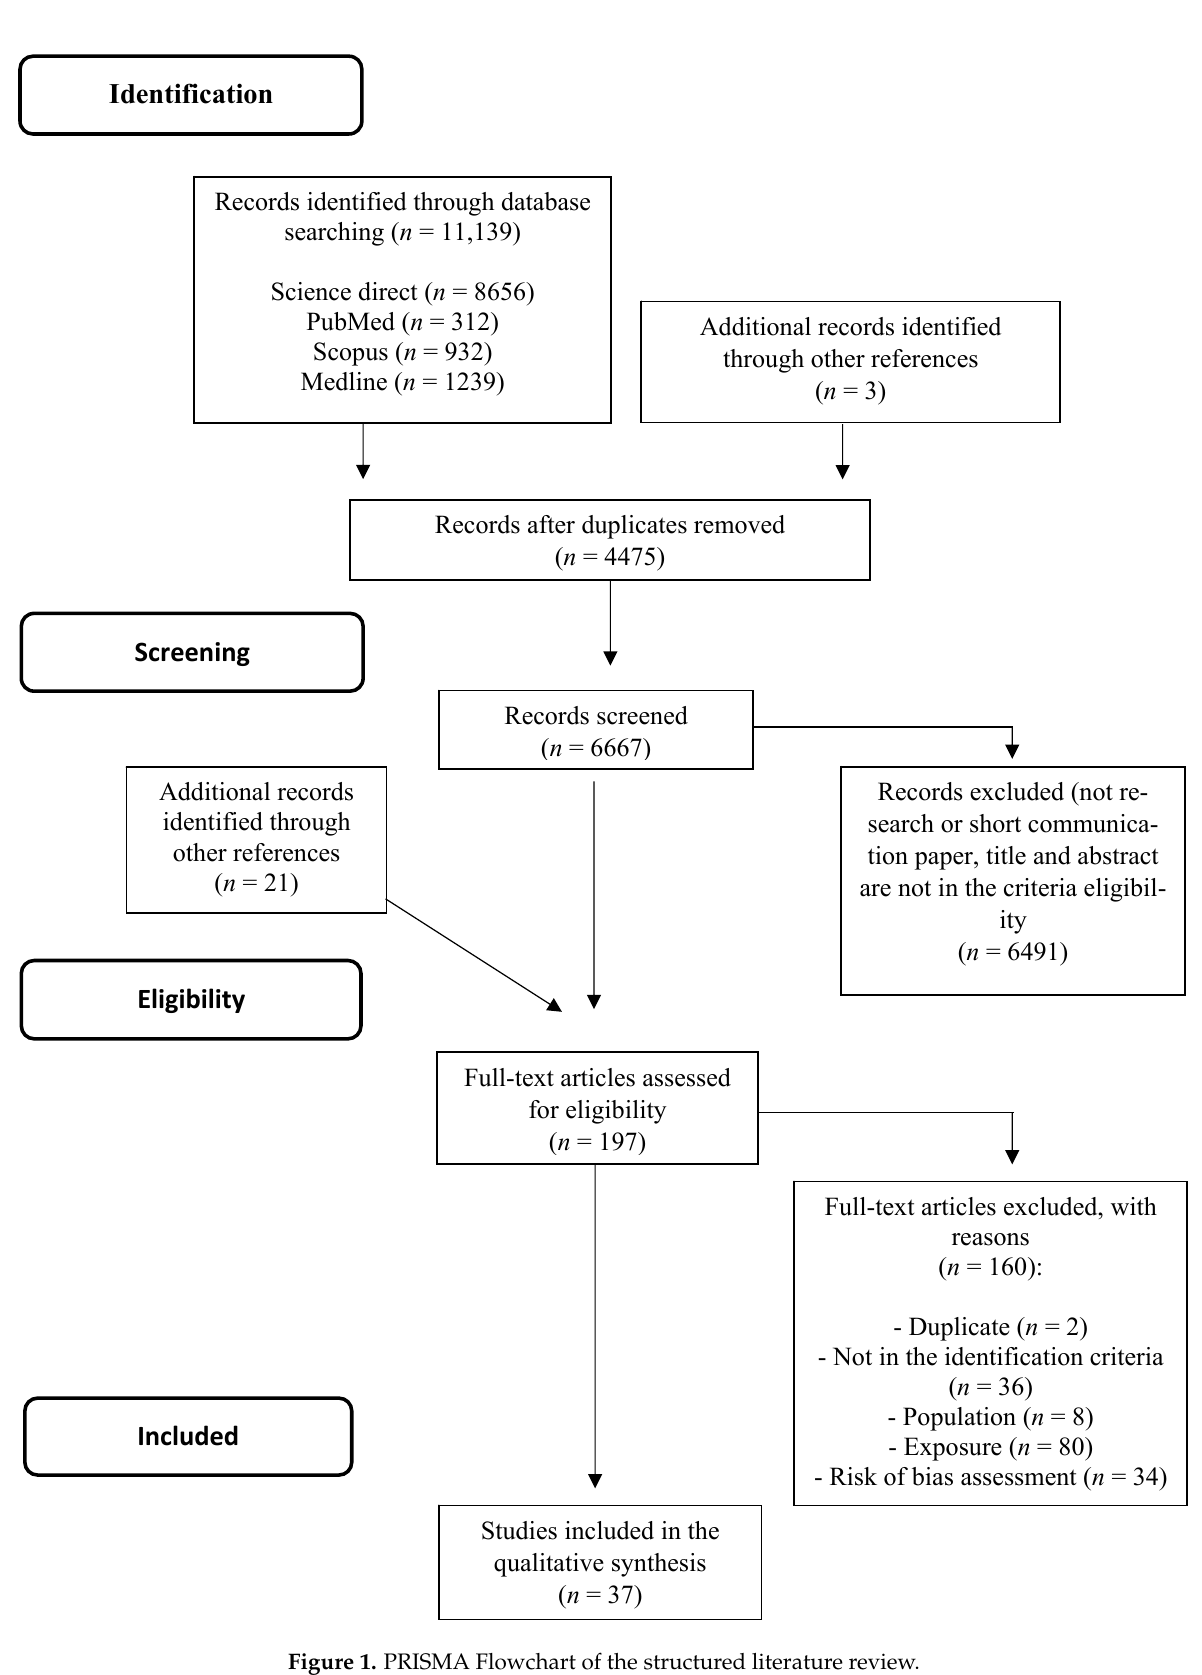
Figure 1. PRISMA Flowchart of the structured literature